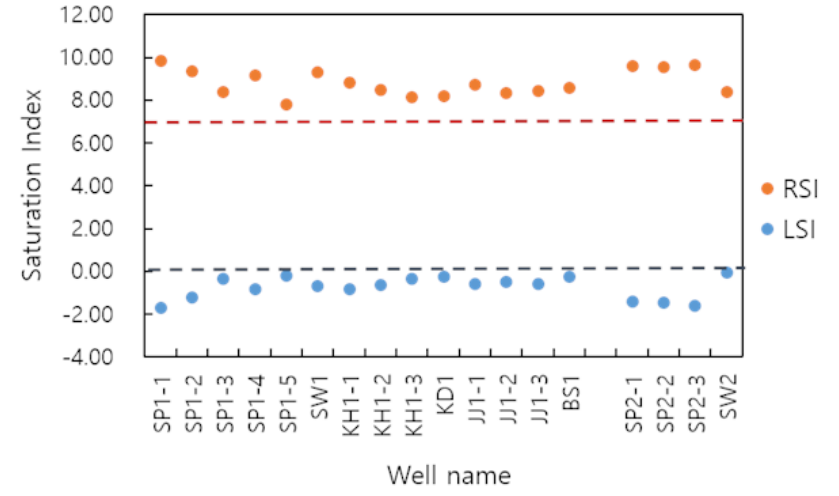
Figure 7. LSI and RSI distribution in pristine groundwater samples, determined by pH and HCO 3 ion concentration. Dotted line means the equilibrium condition with the CaCO 3 of each